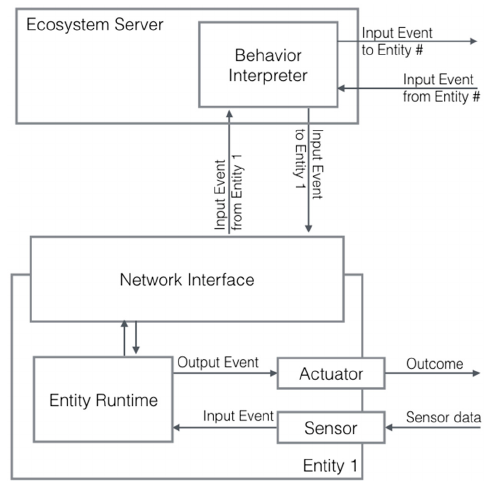
Figure 9. The Entity Runtime. Input events from sensor data and remote events from other entities are interpreted (Behavior Interpreter) and the corresponding output event to another remote endpoint (or to the same entity as well) is generated.